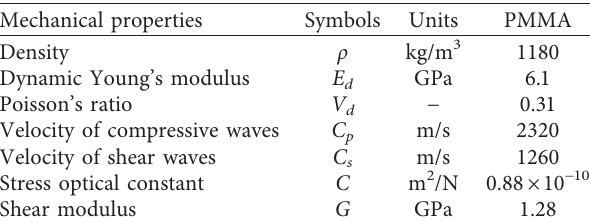
Table 1: Mechanical properties of the